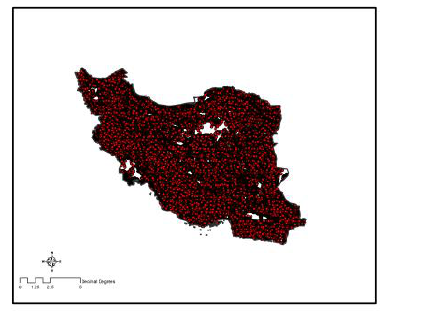
Figure 3: Iran topography map with the contour lines of 100 m